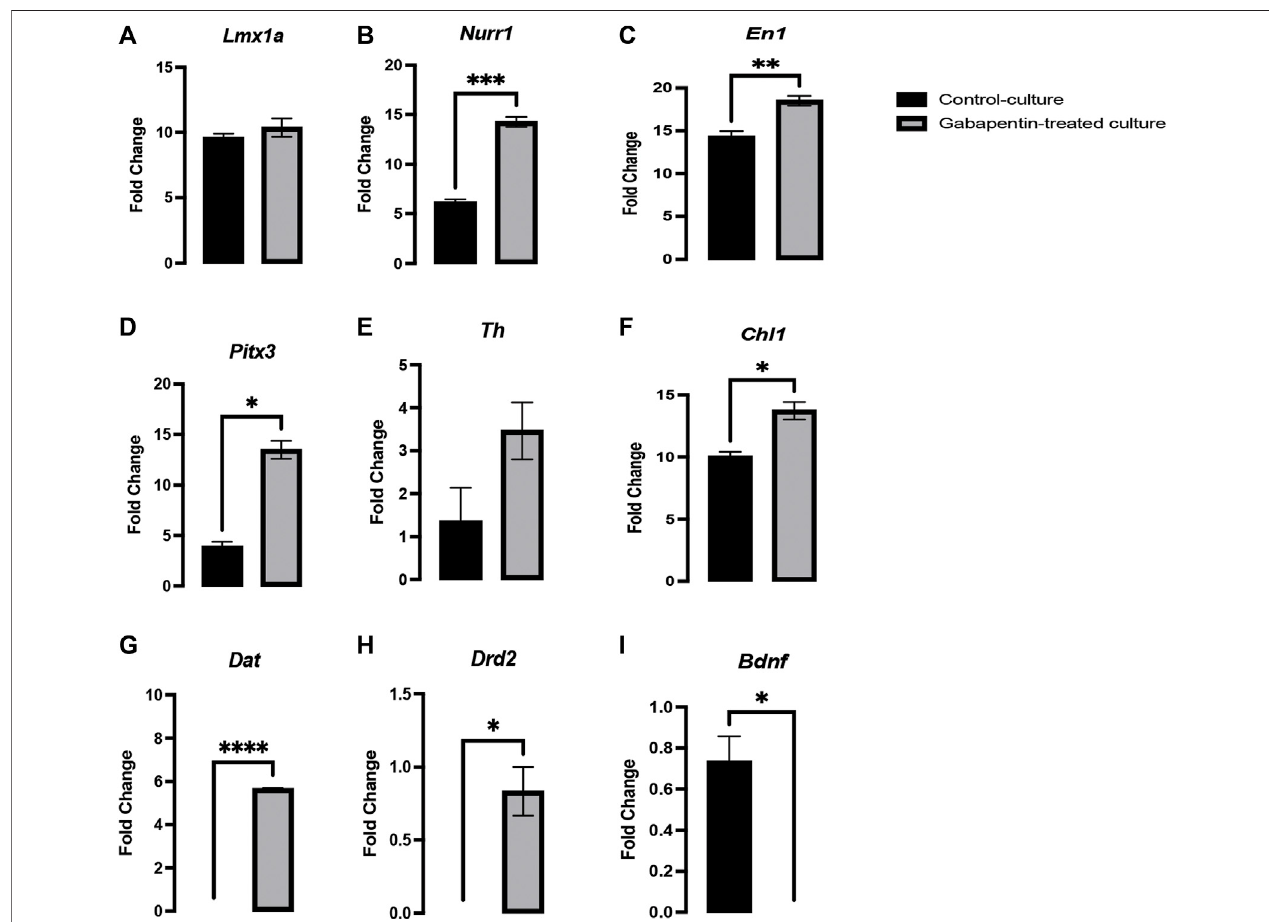
FIGURE 5 | Gabapentin exposure inducing a signi fi cant upregulation in the expression of Nurr1 (B) , En1 (C) , Pitx3 (D) , Chl1 (F) , Dat (G) and Drd2 (H) , signi fi cant downregulation the expression of Bdnf (I) , and no signi fi cant change in the expression of Lmx1a (A) and Th (E) in vmDA neurons.